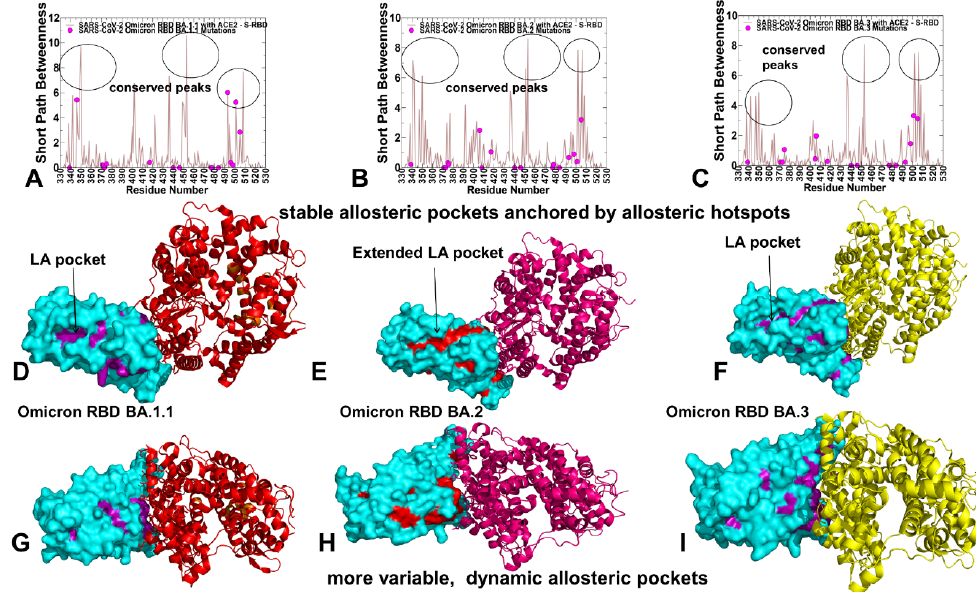
Figure 11. The dynamic network-based analysis of the Omicron RBD subvariant complexes with hACE2. The residue-based SPC centrality profiles of the S-RBD residues for the RBD BA.1.1-hACE2 complex ( A ), RBD BA.2-hACE2 complex ( B ) and RBD BA.3-hACE2 complex ( C ). The distributions are shown in light brown lines and the positions of the Omicron subvariant mutations are highlighted in magenta-colored filled circles. Structural mapping of the SPC distribution peak clusters unveils stable allosteric binding pockets that are anchored by the allosteric hotspots for the RBD BA.1.1-hACE2 complex. The RBD is shown in cyan surface, the pocket regions formed by mediating hotspots are shown in magenta surface and hACE2 is shown in red ribbons. The position of conserved LA allosteric pocket is indicated by an arrow ( D ). Structural mapping of the SPC distribution peak clusters for the RBD BA.2-hACE2 complex. The RBD is shown in cyan surface, the pocket regions formed are shown in red surface and hACE2 is shown in pink ribbons ( E ). Structural mapping of the SPC distribution peak clusters and distribution of allosteric pockets for the RBD BA.3-hACE2 complex. The RBD is shown in cyan surface, the pocket regions formed are shown in magenta surface and hACE2 is shown in green ribbons ( F ). ( G – I ) Structural mapping of the residues with high SPC values from regions different from the top clusters revealed more dynamic allosteric pockets. The annotations for the RBD, hACE2 and predicted pockets are same as in panels ( D – F ).